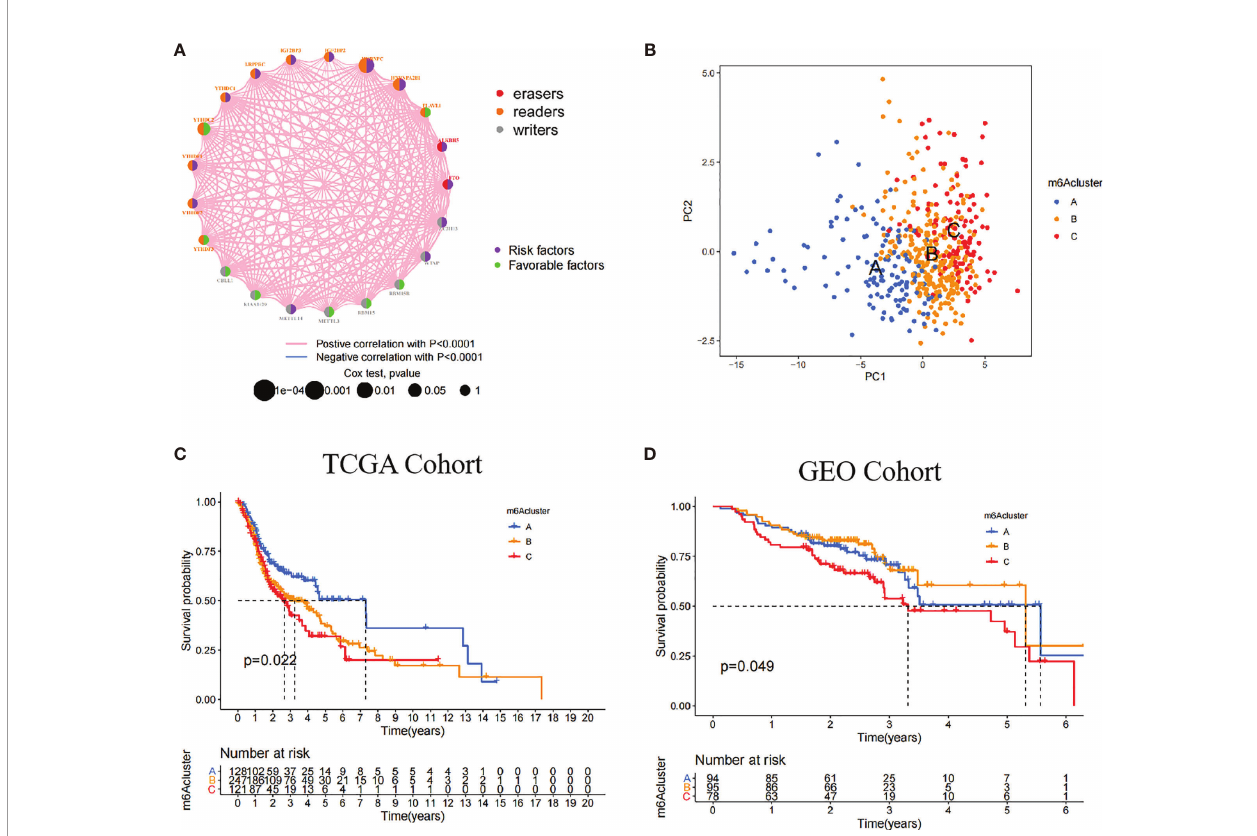
FIGURE 2 | Patterns of m 6 A methylation modi fi cation. (A) The interaction of 21 m 6 A regulators in HNSCC. The different RNA modi fi cations were depicted by different colored circles. Readers, orange; writers, gray; erasers, red. Favorable factors were indicated by the green circle, and risk factors were indicated by the purple circle. (B) The remarkable difference between different three m 6 A clusters was plotted via principal component analysis. (C) Kaplan-Meier curves of overall survival (OS) in TCGA cohort with three m 6 A clusters ( p = 0.022). (D) Kaplan-Meier curves of overall survival (OS) in GEO cohort with three m 6 A clusters ( p = 0.049). The patients in m 6 A cluster C showed worse OS than in other